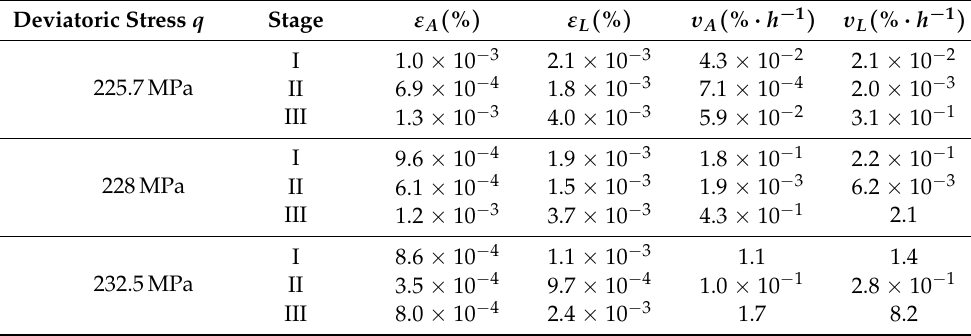
Figure 2. The curves of deviatoric stress versus strain for Beishan granite specimens under triaxial compression with different confining pressures. Note that in the case of 15 MPa, the samples was experiencing a post-peak failure which leads to the sudden lateral strain drop at the strain range around − 1.4%. ( a ) Axial and lateral strain; ( b ) Volumetric strain. Table 1. Comparison of single-stage creep test results between Beishan